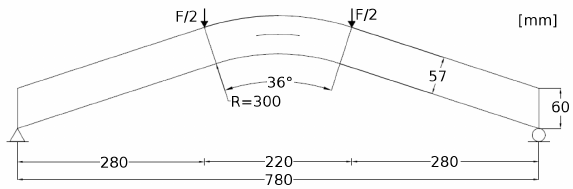
Figure 4. Scheme of 4PBT of Yellow Poplar LVL arch with a through pre-crack in its crown.